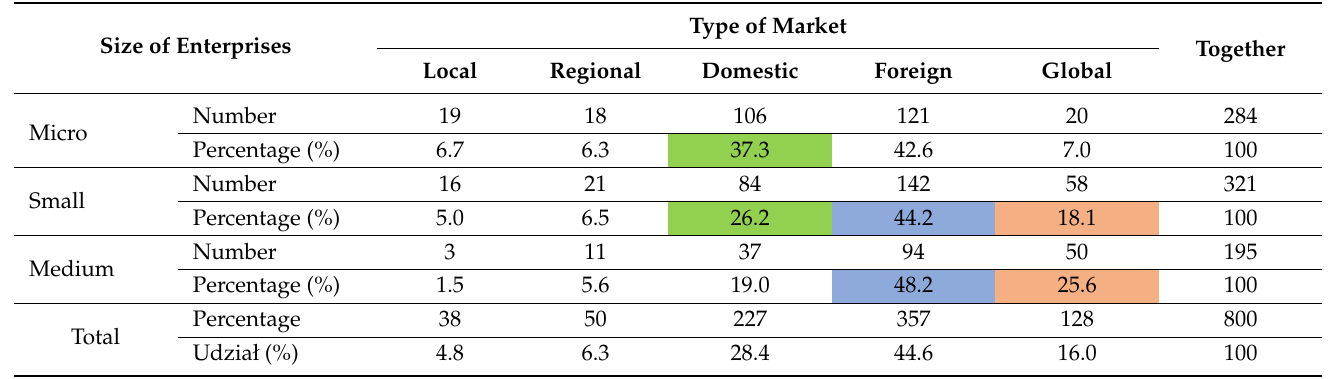
Table 5. Division of the study sample by